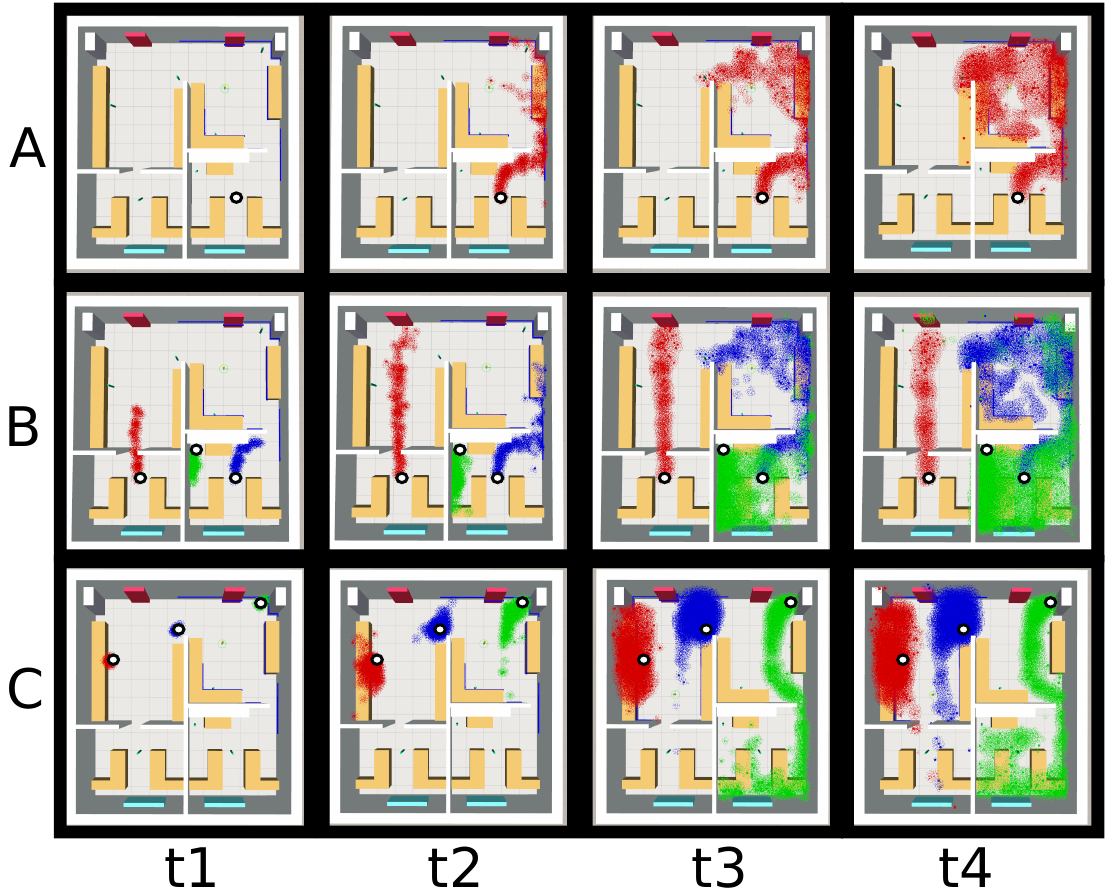
Figure 6. Snapshots of the gas dispersion at four time-steps ( t1 – t4 ) for three different scenarios ( A – C ) varying the wind flow, number and location of the gas sources. ( A ) when only one gas source is present and the wind flows from bottom to top (see Figure 3D); ( B ) introducing a total of three gas sources under similar wind flow conditions; and ( C ) changing the main wind flow from top to bottom (see Figure 3C) and setting three different gas sources. To allow an easy differentiation of the multiple gases, each one has been colored